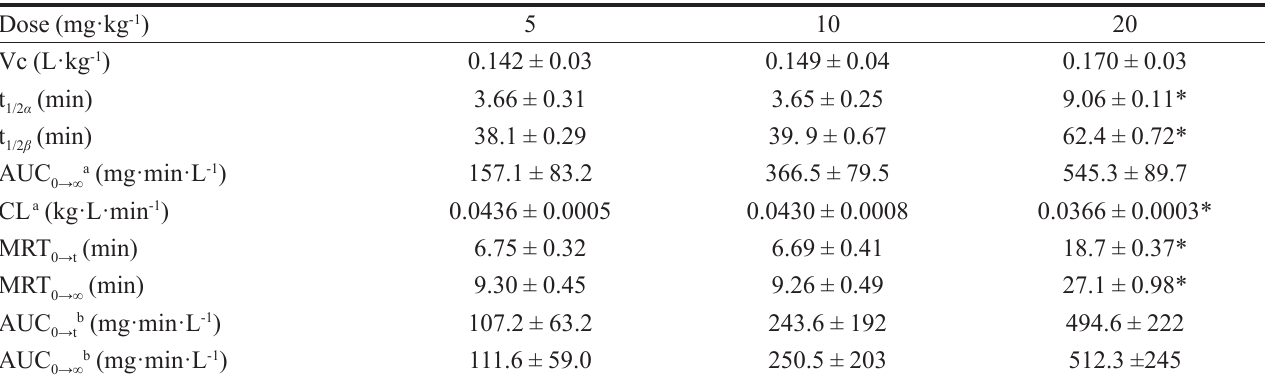
TABLE II - Pharmacokinetic parameters of isoquercitrin in rats (mean ± S.D., n = 5) after the intravenous administration of doses of 5, 10 and 20 mg·kg